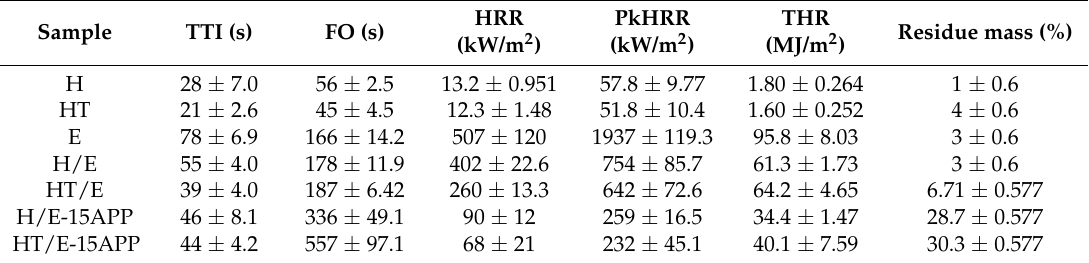
Table 3. Results from cone calorimetry tests performed on hemp and on the different composites before and after the waterglass treatment. TTI, Time To Ignition; FO, time to Flame Out; HRR, Heat Release Rate; pkHRR, peak of the Heat Release Rate; THR, Total Heat Released. Sample